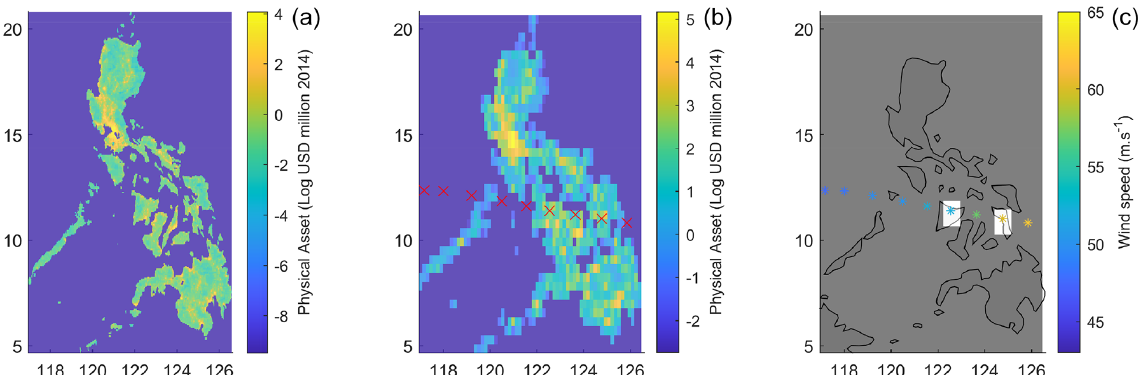
Figure 19. Illustration of the high-resolution asset data (a) original physical asset value resolution. (b) Aggregation of the asset value over 0 . 25 ◦ boxes to evaluate asset exposure along the interpolated cyclone track (here corresponding to the 2013 Hayan cyclone). (c) Illustration of damage calculation: damage is aggregated over the white boxes which correspond to cyclone locations over land.